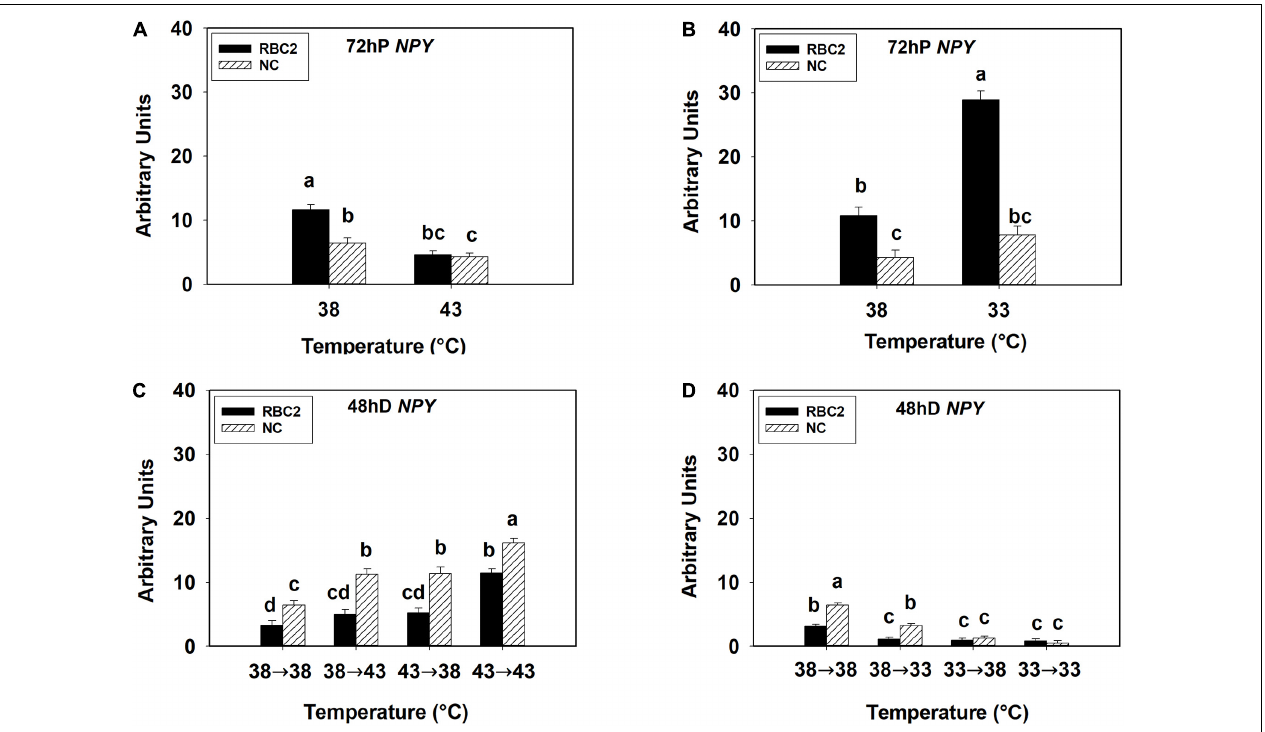
FIGURE 3 | Expression of neuropeptide Y ( NPY ) at 72 h of proliferation (72 hP) and 48 h of differentiation (48 hD) in satellite cells isolated from the pectoralis major (p. major) muscle of 7-day-old Randombred Control Line 2 (RBC2) and 7-day-old Nicholas Commercial (NC) turkeys. (A) Satellite cell proliferation at 38 ◦ or 43 ◦ C for 72 h. (B) Satellite cell proliferation at 38 ◦ or 33 ◦ C for 72 h. (C) Satellite cell proliferation for 72 h and differentiation for 48 h, both at 38 ◦ C (38 ◦ → 38 ◦ C); proliferation at 38 ◦ C for 72 h and differentiation at 43 ◦ C for 48 h (38 ◦ → 43 ◦ C); proliferation at 43 ◦ C for 72 h and differentiation at 38 ◦ C for 48 h (43 ◦ → 38 ◦ C); or proliferation for 72 h and differentiation for 48 h, both at 43 ◦ C (43 ◦ → 43 ◦ C). (D) Satellite cell proliferation for 72 h and differentiation for 48 h, both at 38 ◦ C (38 ◦ → 38 ◦ C); proliferation at 38 ◦ C for 72 h and differentiation at 33 ◦ C for 48 h (38 ◦ → 33 ◦ C); proliferation at 33 ◦ C for 72 h and differentiation at 38 ◦ C for 48 h (33 ◦ → 38 ◦ C); or proliferation for 72 h and differentiation for 48 h, both at 33 ◦ C (33 ◦ → 33 ◦ C). Each graph bar represents a mean arbitrary unit, and each error bar represents a standard error of the mean. Mean values without a same letter were significantly different ( P ≤